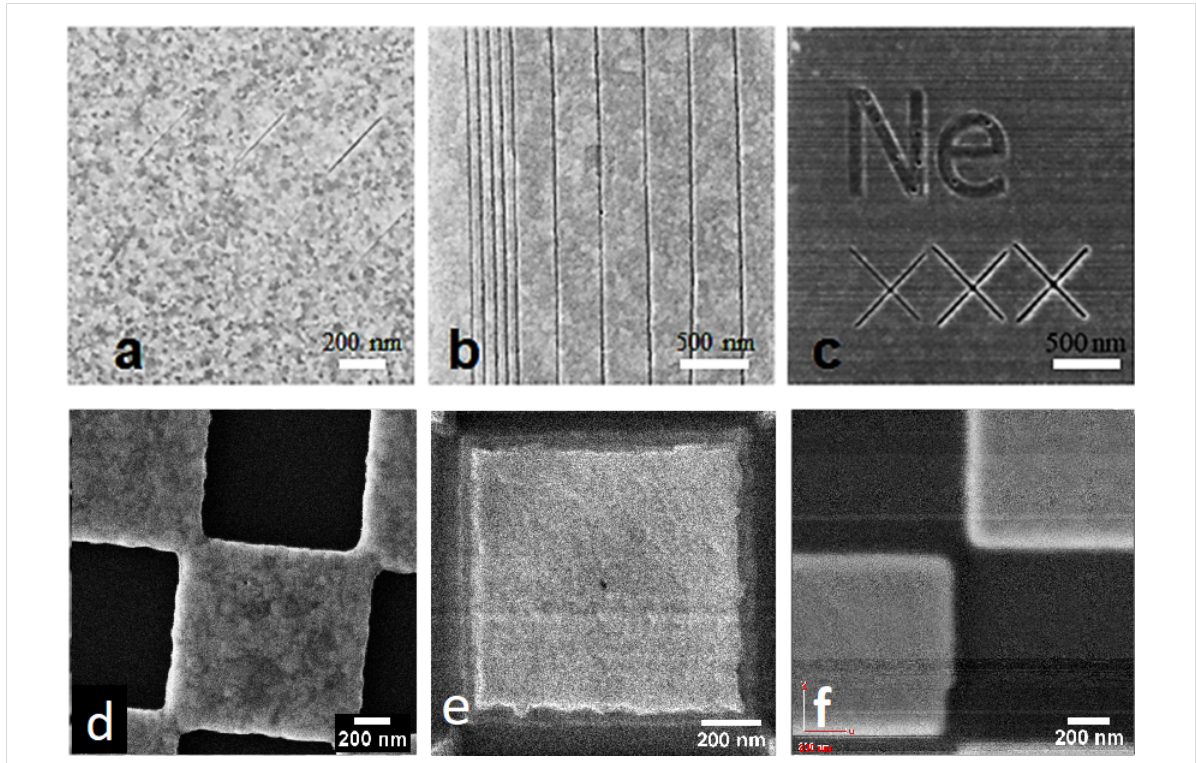
Figure 3: Examples using different ions: a) 30 keV He + , field of view (FOV): 1.5 × 1.5 µm 2 , trench width: 4 nm, b) 40 keV Li + , FOV: 2.5 × 2.5 µm 2 , trench width: 6 nm, c) 25 keV Ne + , FOV: 2.5 × 2.5 µm 2 , trench width: 12 nm, d) 70 keV Be ++ , FOV: 1.9 × 1.9 µm 2 , best imaging res: (4.0 ± 0.5) nm, e) 35 keV Li + , FOV: 1.2 × 1.2 µm 2 , best imaging res: (2.9 ± 0.5) nm, f) 35 keV B + , FOV: 1.6 × 1.6 µm 2 , best imaging res: (19 ± 2) nm.